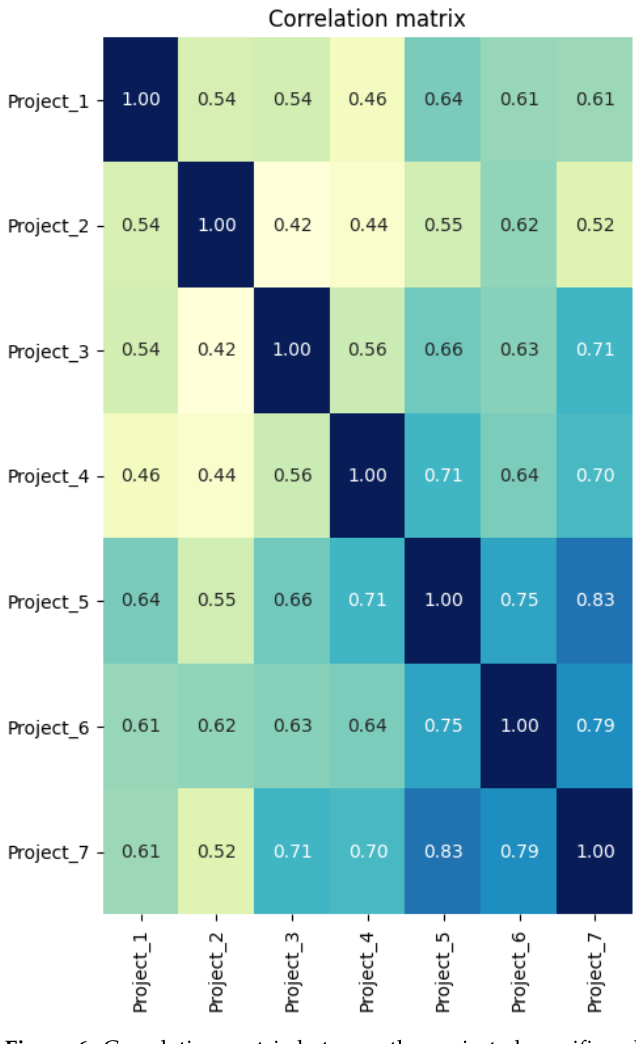
) of the individual projects ij V ) of the individual projects нij R